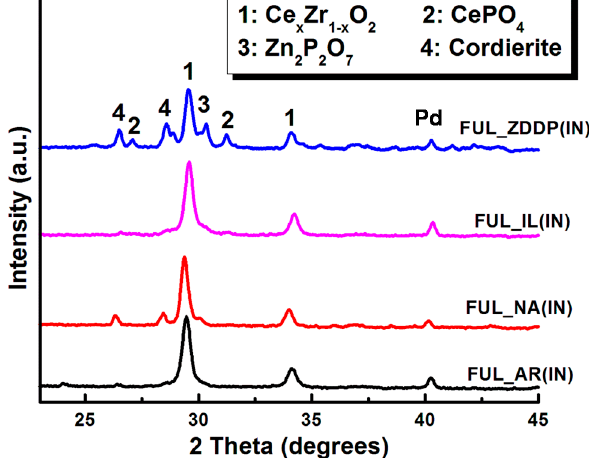
Figure 2. X ‐ ray Diffraction (XRD) patterns for the inlet portion of the three way catalysts (TWCs). Figure 2. X-ray Diffraction (XRD) patterns for the inlet portion of the three way catalysts